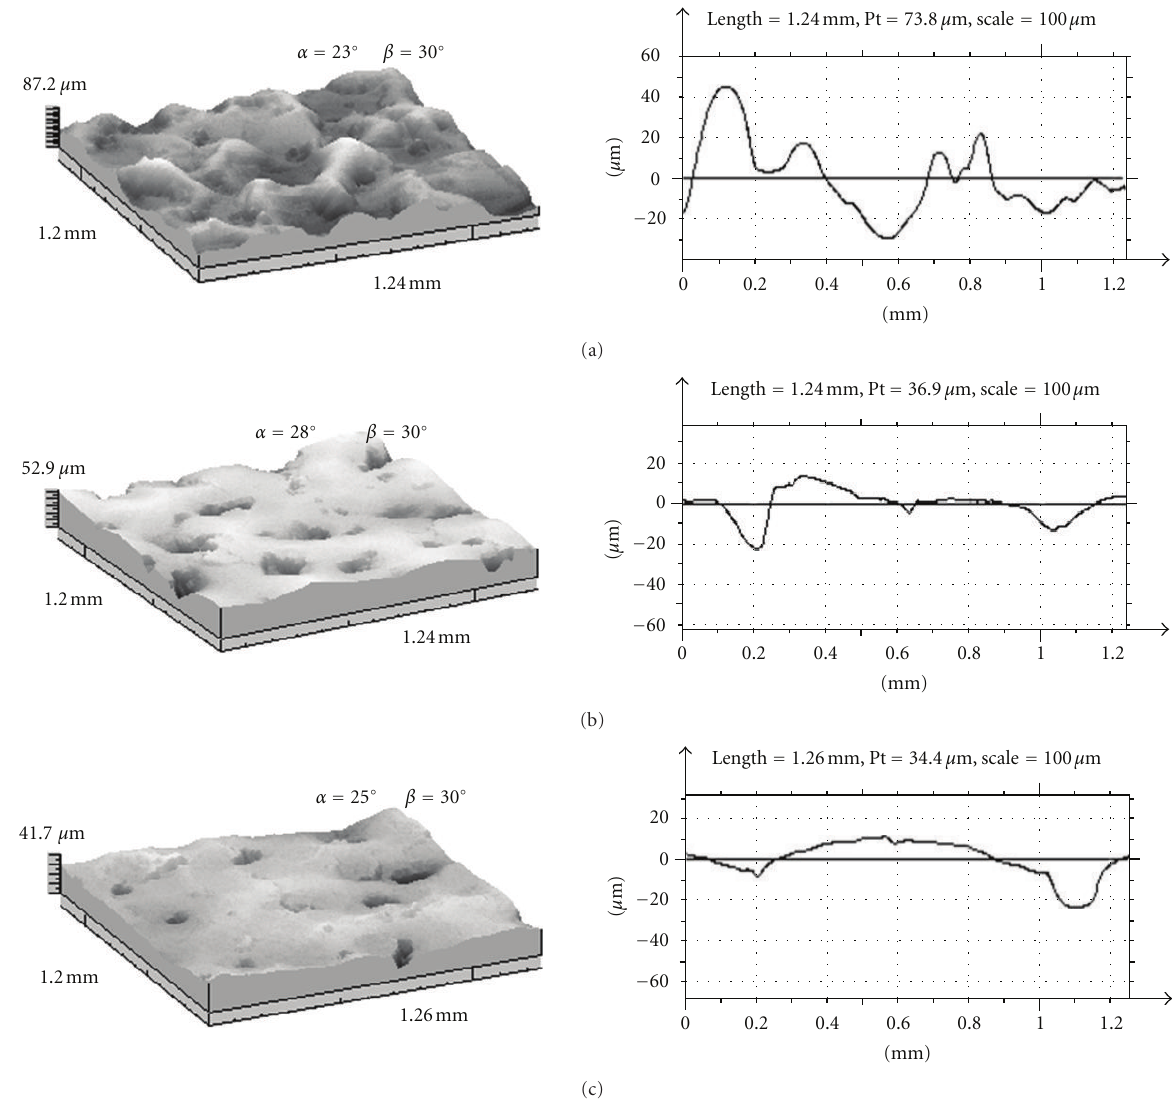
Figure 4: Stereometric image of surface after machining and its profilogram (a) the EDM— U = 120 (V), I = 24 (A), Ti = 200 ( μ s), and the following roto-peen (b) n = 6500 (rev/min), t = 2 . 5 (min), (c) n = 6500 (rev/min), t =